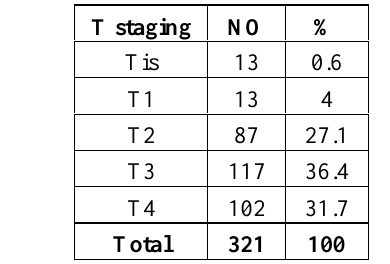
Table VII. Patients according to T staging